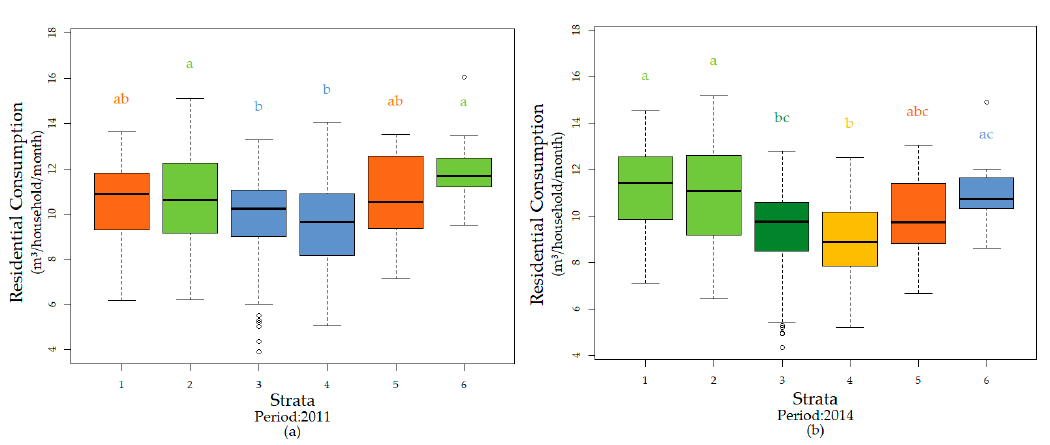
Figure 2. Result of comparison test on consumption between strata ( a ) Period 2011; ( b ) Period 2014. Note: Different significances are presented with different letters ( p < 0.1) between strata per year, in the following way: a = a, ab = a, ab = b, a < >